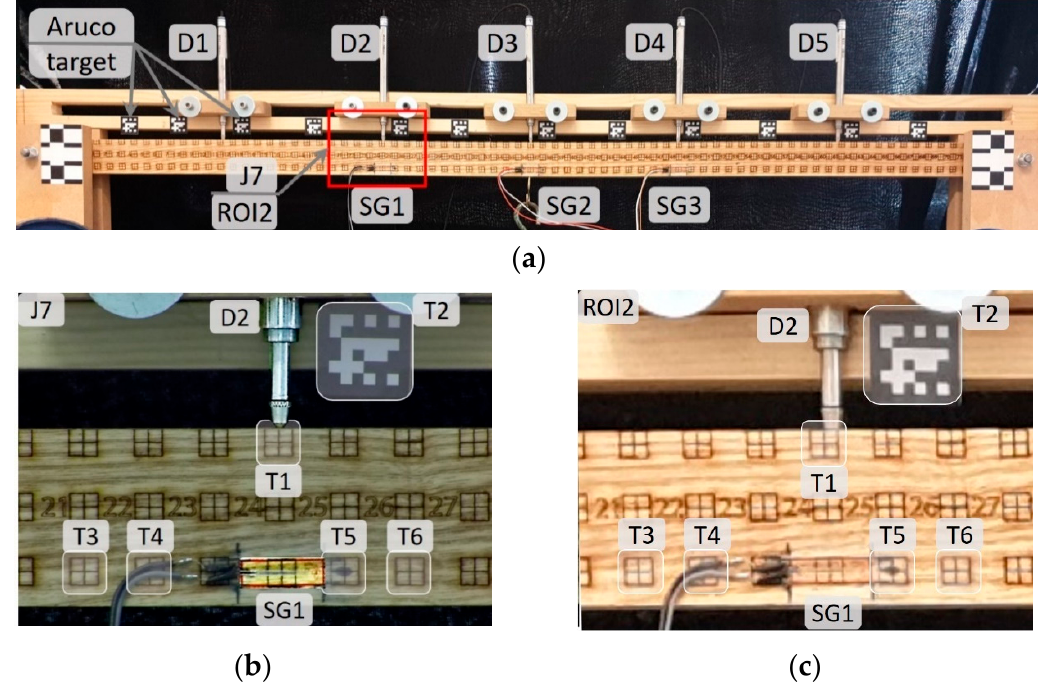
Figure 7. Annotated images collected with vision-based monitoring systems. ( a ) A cropped image captured with a smartphone. Sensor names are provided next to sensor locations. The red rectangle shows the part of the beam captured at J7 and in ROI2. ( b ) and ( c ) targets and sensor locations in J7 and ROI2, respectively.